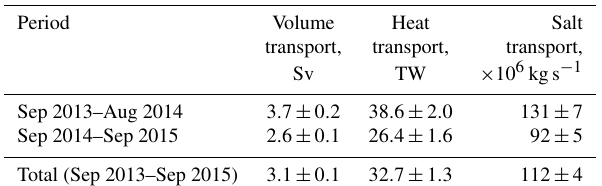
Table 4. Atlantic Water heat, salt, and volume transports across the 125 ◦ E section in 2013–2015.